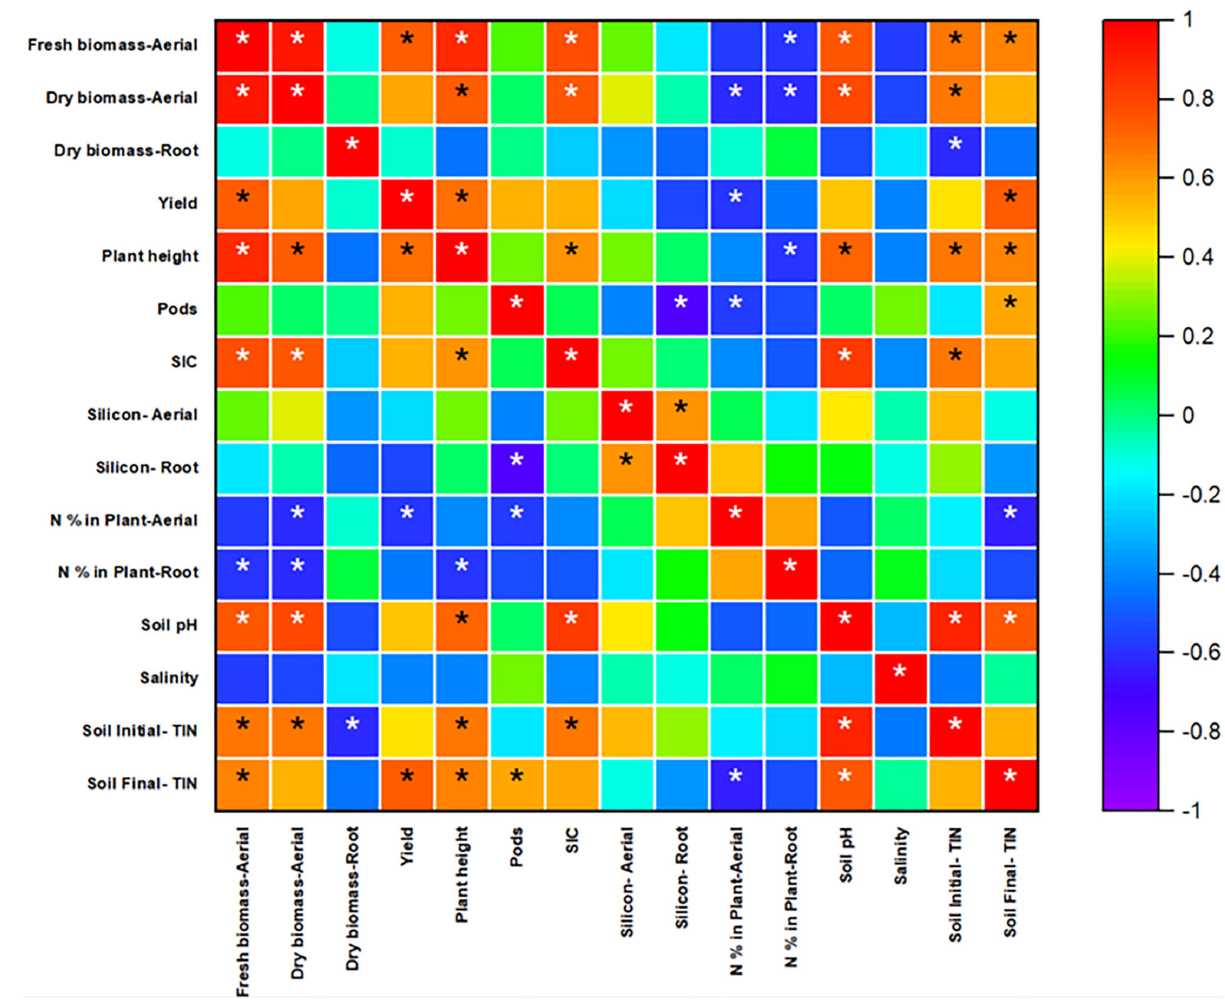
aluminum, also affect the silicon uptake (Jones and Handreck,